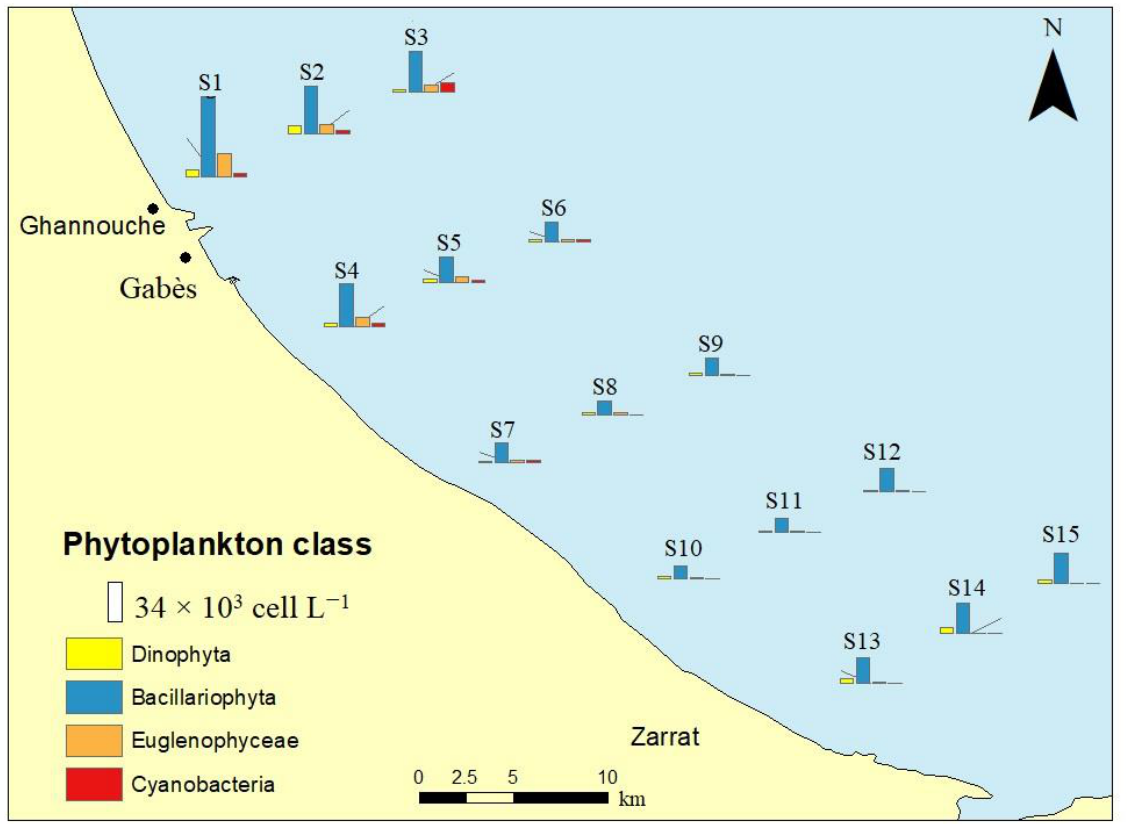
Figure 5. Phytoplankton class abundance at sampled stations (number beside the bar indicates the scale of abundance).